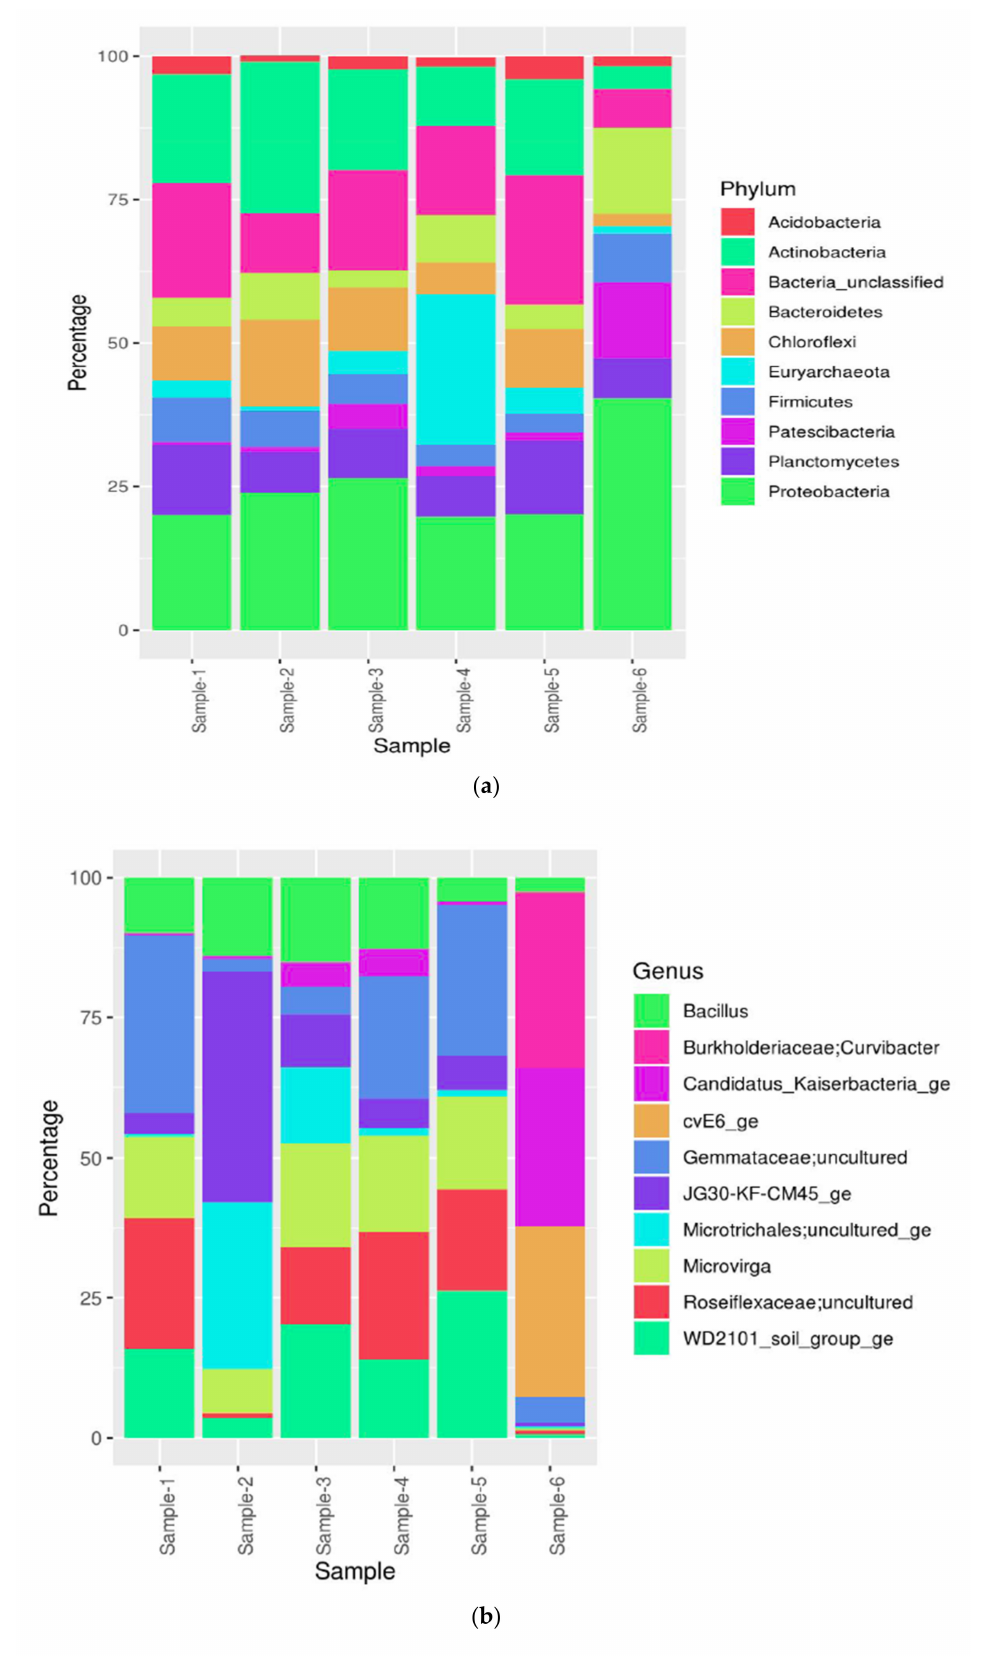
Figure 3. ( a ) Top 10 Phyla abundance distribution. ( b ) Top 10 Genus abundance in coloured